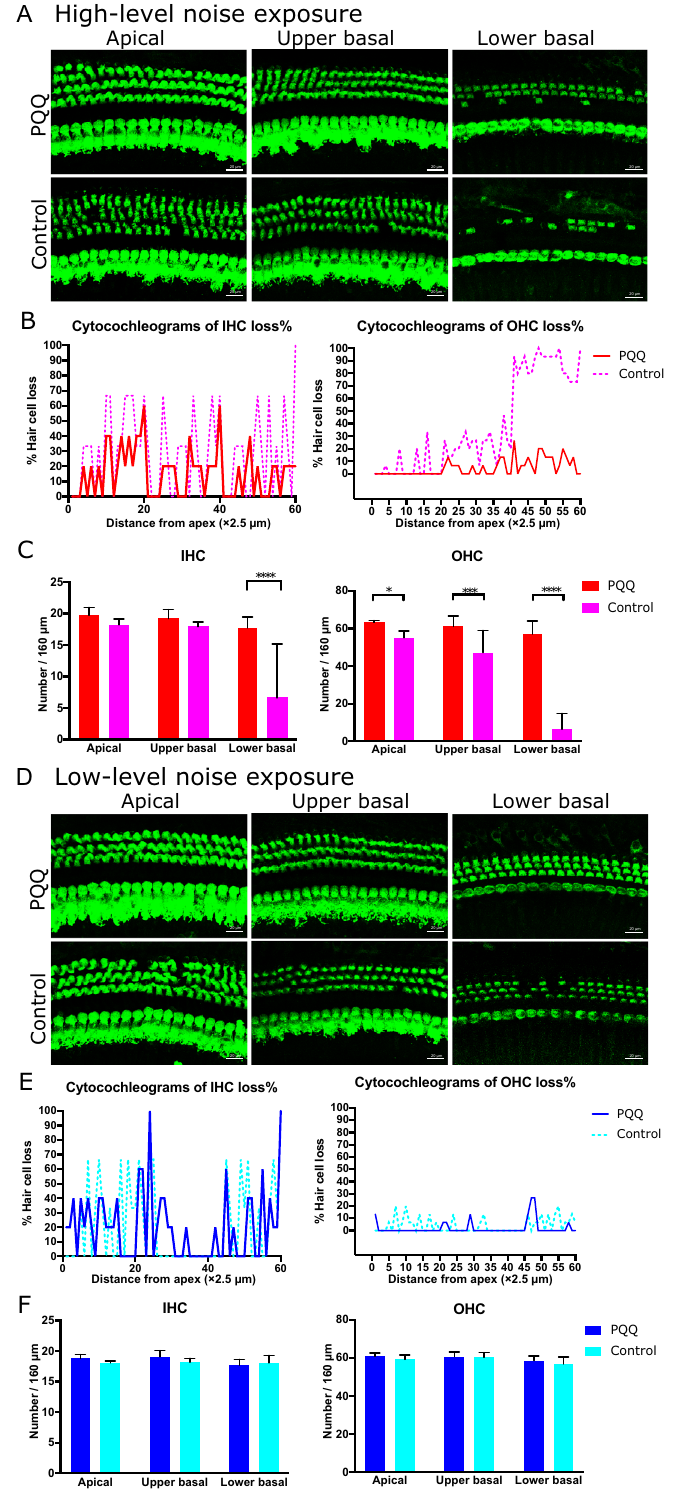
Figure 2. The histological evaluation of hair cells in the noise-induced hearing loss model ( A ) Morphological changes of hair cells after exposure to high-level noise in the apical, upper basal and lower basal turns of the cochlea in the PQQ group and control group. The hair cells are stained with Myo7A (green). Bar, 20 µm. ( B ) The cytocochleograms of IHCs (left) and OHCs (right) for each group. The graphs show the survival rates of IHCs (left) and OHCs (right) as a function of their distance from the apex of the cochlea. ( C ) The numbers of IHCs and OHCs of the sensory epithelium per 160 µm for PQQ and control groups. ( D ) , ( E ) , ( F ) A, B and C above (respectively) but for low-level noise exposure. * p < 0.05, *** p < 0.001, **** p < 0.0001. ( n = 5 per